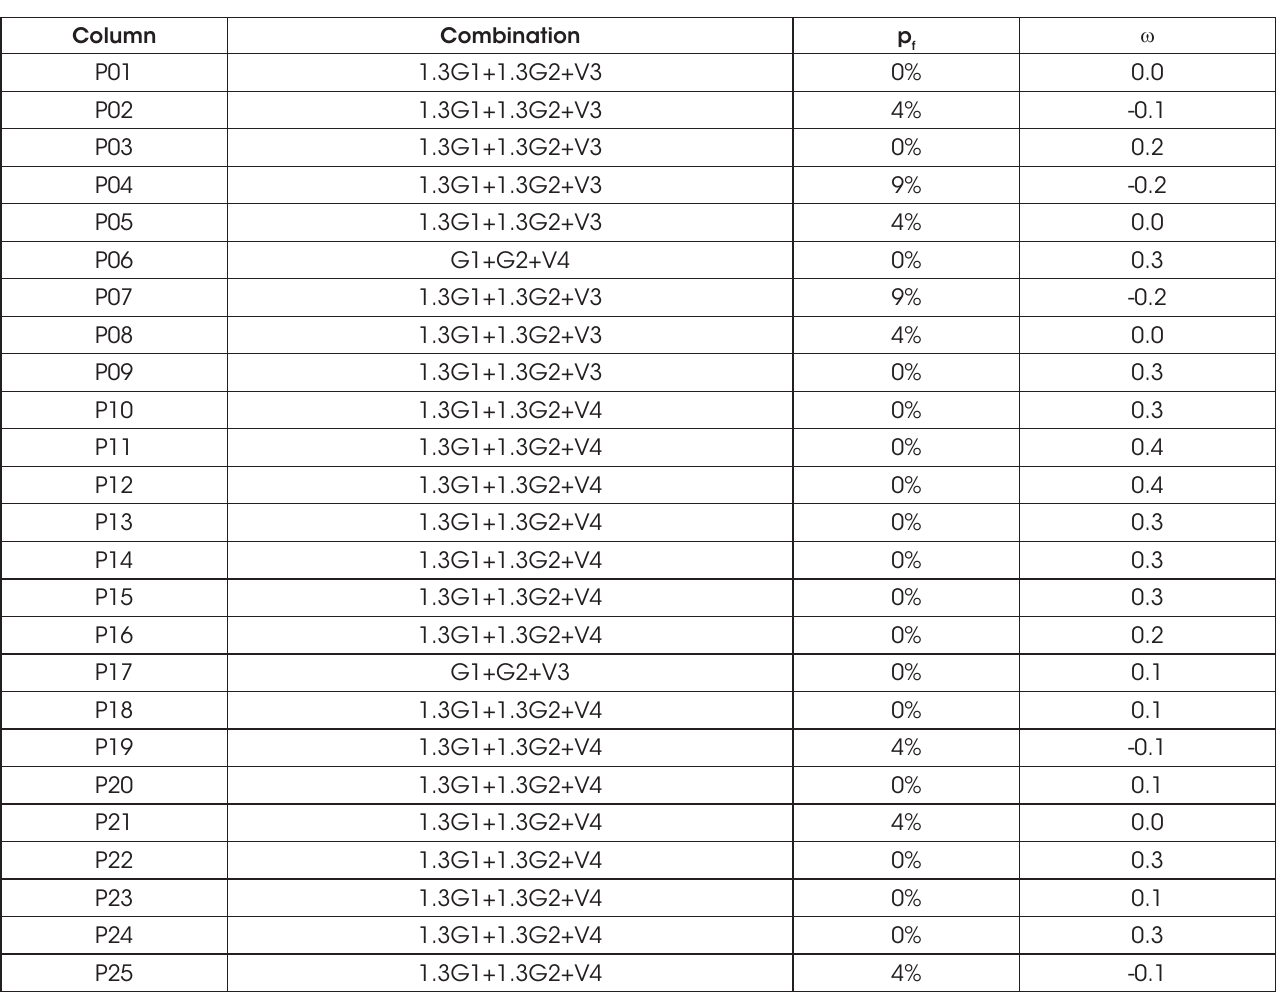
Columns’ situation at the collapse